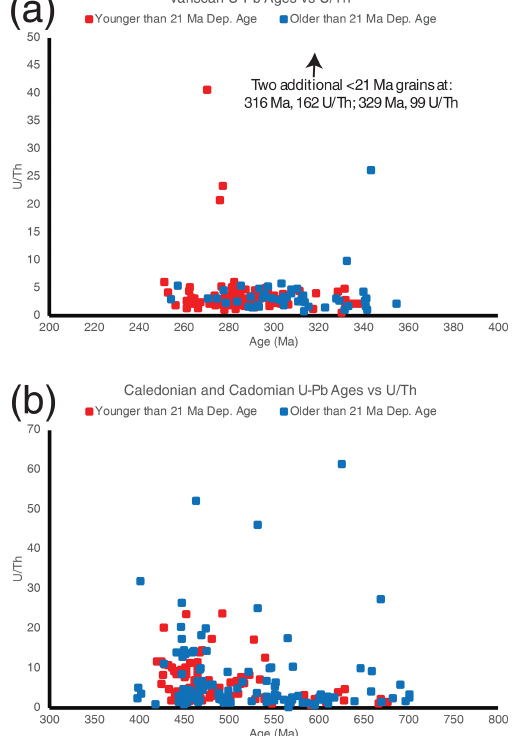
Figure 8. Age vs. U / Th comparison for detrital zircon grains with depositional ages older than 21Ma and younger than 21Ma. (a) Variscan aged grains; (b) Caledonian and Cadomian age grains. Although not definitive, grains with elevated U / Th (or low Th / U; e.g., Rubatto et al., 2002) have a higher likelihood of being meta- morphic in origin. There are few Variscan grains with elevated U / Th from both the pre- and post-21Ma depositional ages, sug- gesting little input of metamorphic sources for these ages. There are a large number of Caledonian and a handful of Cadomian grains with elevated U / Th from both the pre- and post-21Ma depositional ages, indicating the metamorphic sources for these age grains are prevalent.